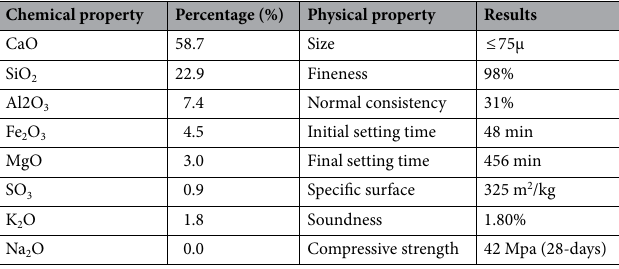
Table 1. Physical and chemical property of